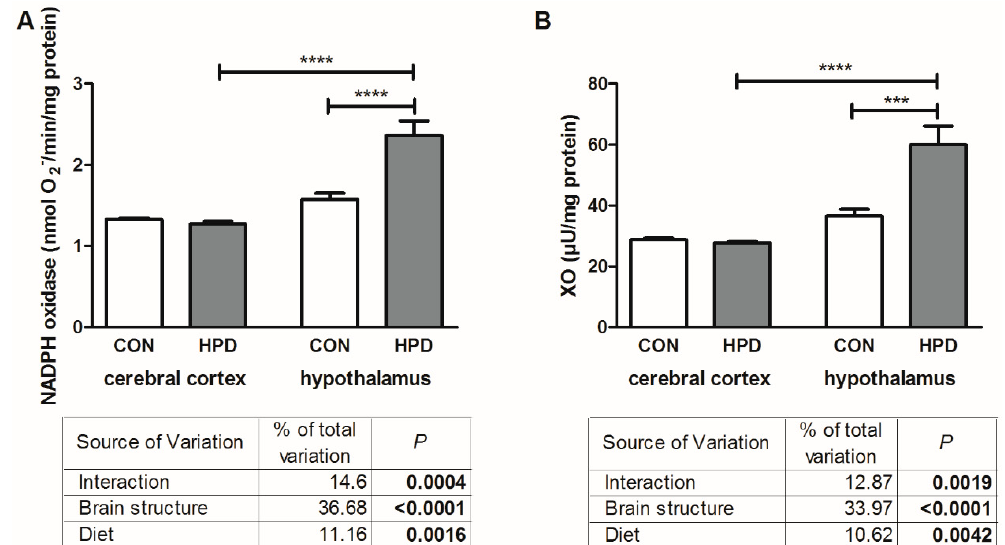
Figure 1. Effect of 8-week HPD on pro-oxidant enzymes (NADPH oxidase ( A ), XO ( B )) in rat cerebral cortex and hypothalamus. Values are means ± SEMs, n = 9. Differences statistically significant at: *** p < 0.0005, **** p < 0.0001. CON, standard diet; HPD, high protein diet; XO, xanthine oxidase.